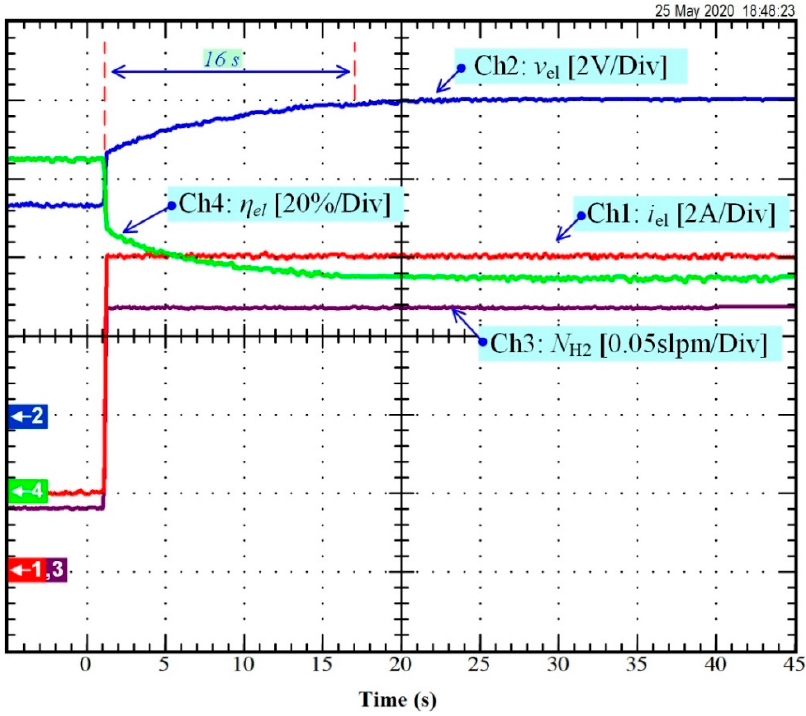
Figure 11. Voltage response as a result of a step current from 2 up to 8 A.